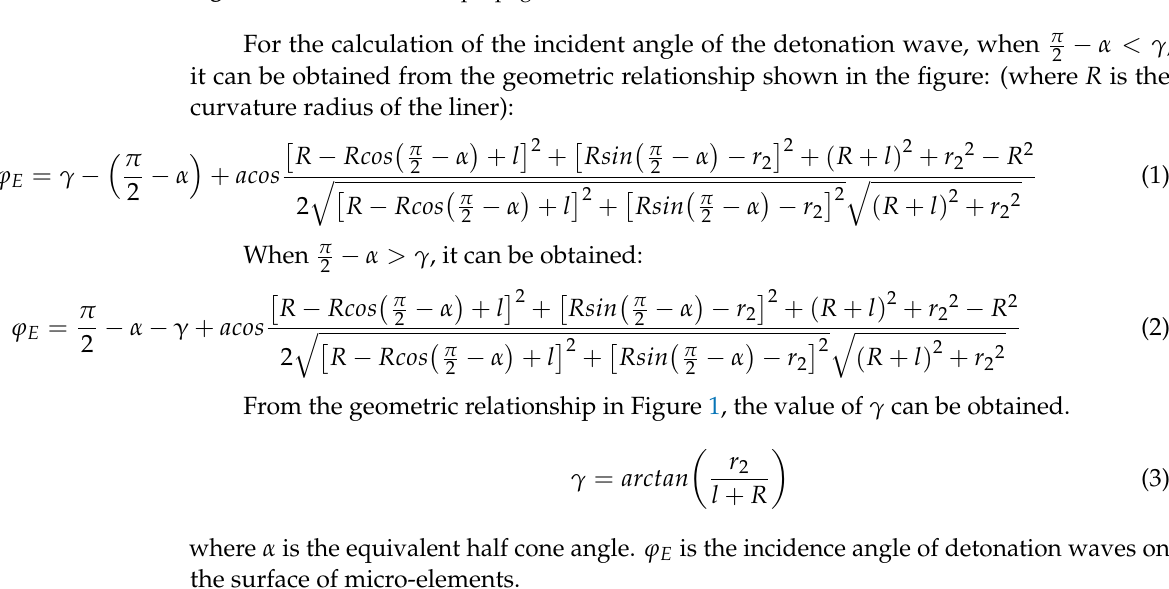
Figure 1. Detonation wave propagation in DLSC.